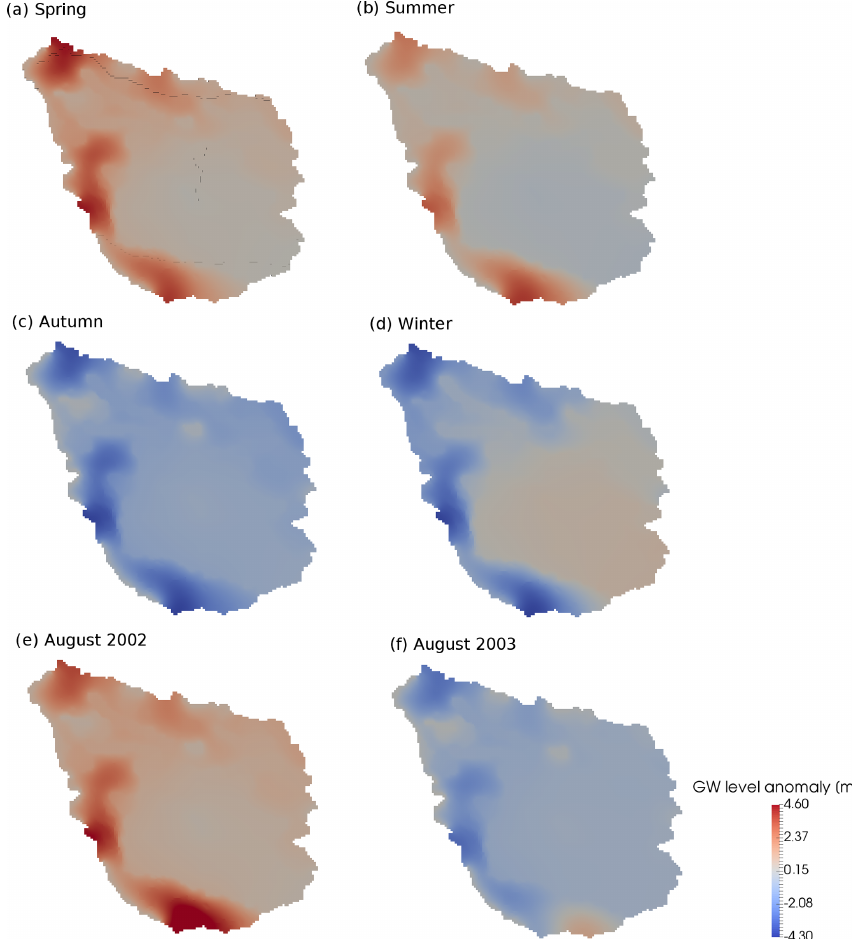
Figure 12. Seasonal variation in spatially distributed groundwater heads by their anomalies after removing the long-term mean groundwater heads (unit: m). (a) Long-term mean groundwater head distribution in spring; (b) long-term mean groundwater head distribution in summer; (c) long-term mean groundwater head distribution in autumn; (d) long-term mean groundwater head distribution in winter; (e) monthly mean groundwater head distribution in the wet season (August 2002); (f) monthly mean groundwater head distribution in the dry season (August